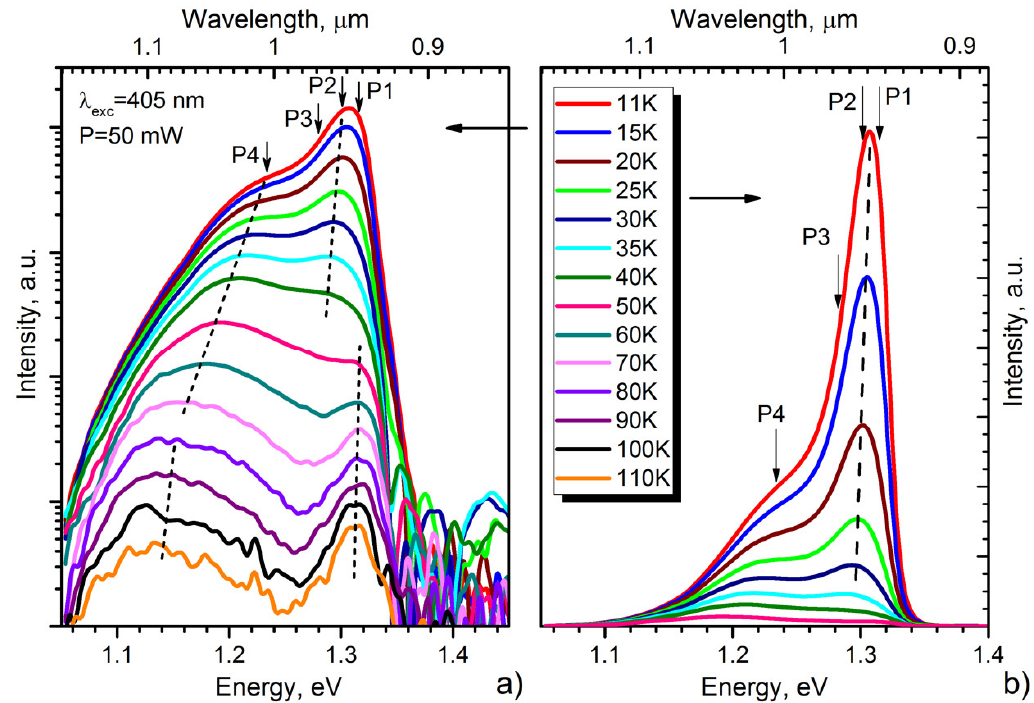
Figure 12. Photoluminescence spectra of the InSe / GaAs(001) layer (sample # IS1 ) at a low excitation power of 0.5 W / cm 2 in logarithmic ( a ) and linear ( b ) scales measured at di ff erent temperatures. The colors of the curves correspond to the legend presented in ( b ). The P1 , P2 , P3 and P4 peaks correspond to those shown in Figure S6. The dashed lines are shown for eyes only and correspond to temperature shift of the respective peak maxima.